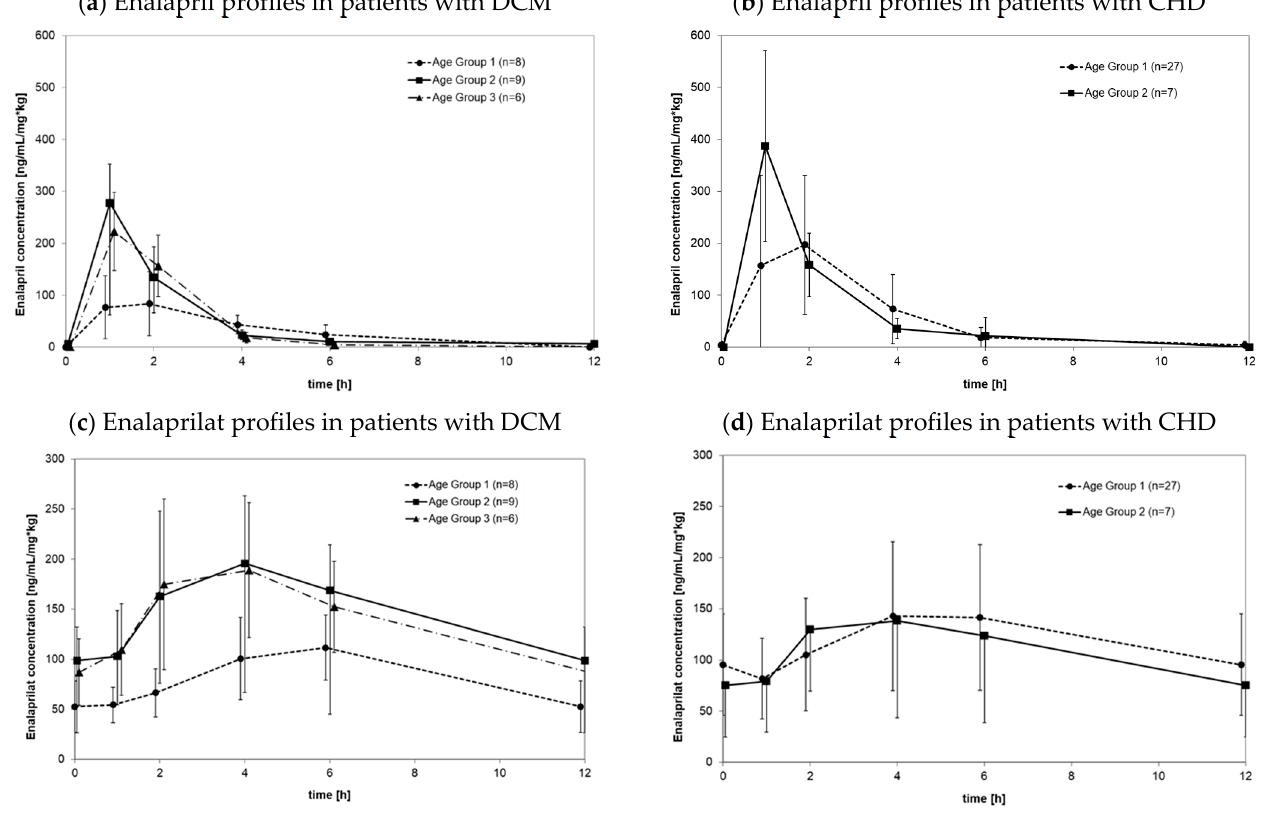
Figure 1. Enalapril ( a , b ) and enalaprilat ( c , d ) profiles of plasma concentrations over time with serum samples normalized by dose and bodyweight in steady state conditions in patients with heart failure due to dilated cardiomyopathy ( a , c , n = 23) and congenital heart disease ( b , d , n = 34) where profiles were measured under steady state conditions. Profiles were grouped according to age: Age group 1: 1 day to <1 year; Age group 2: 1 year to <6 years; age group 3: 6 years to <12 years.